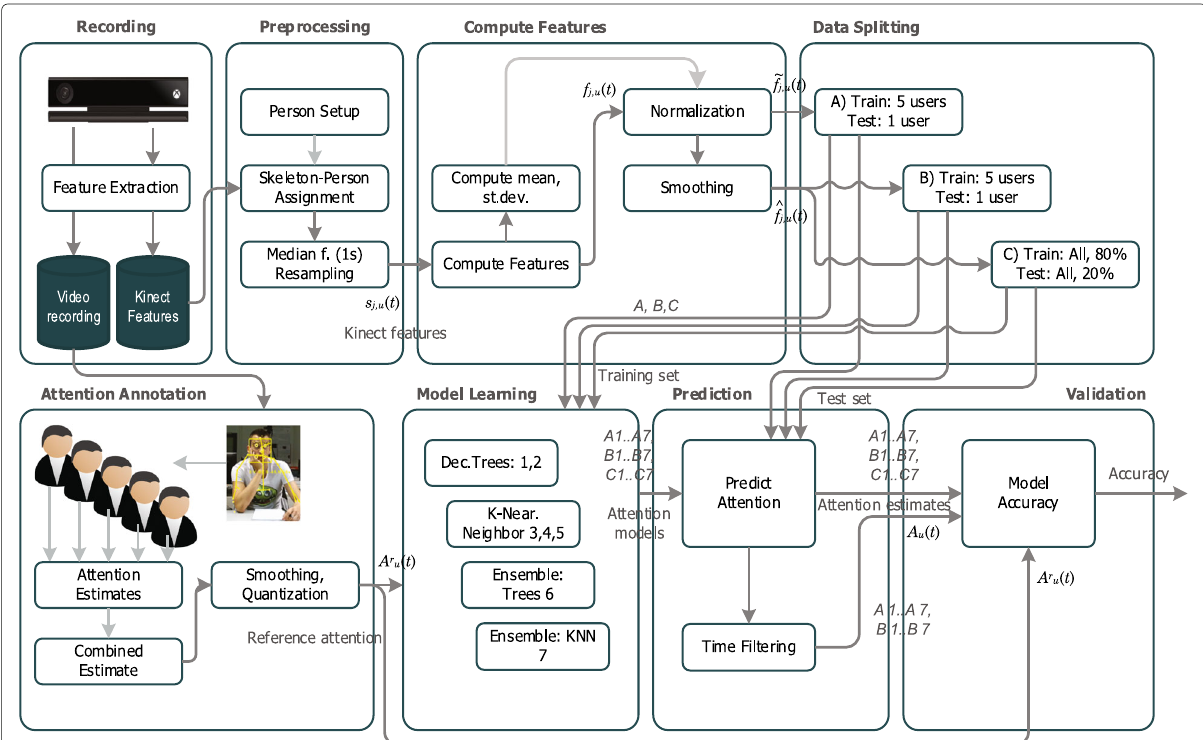
Fig. 4 Data processing diagram. Feature set for machine learning is computed from pre-processed Kinect features, and reference attention is provided by five human observers. Several classifiers are learned from the feature samples and the reference attention data, and model accuracy is computed on the test data